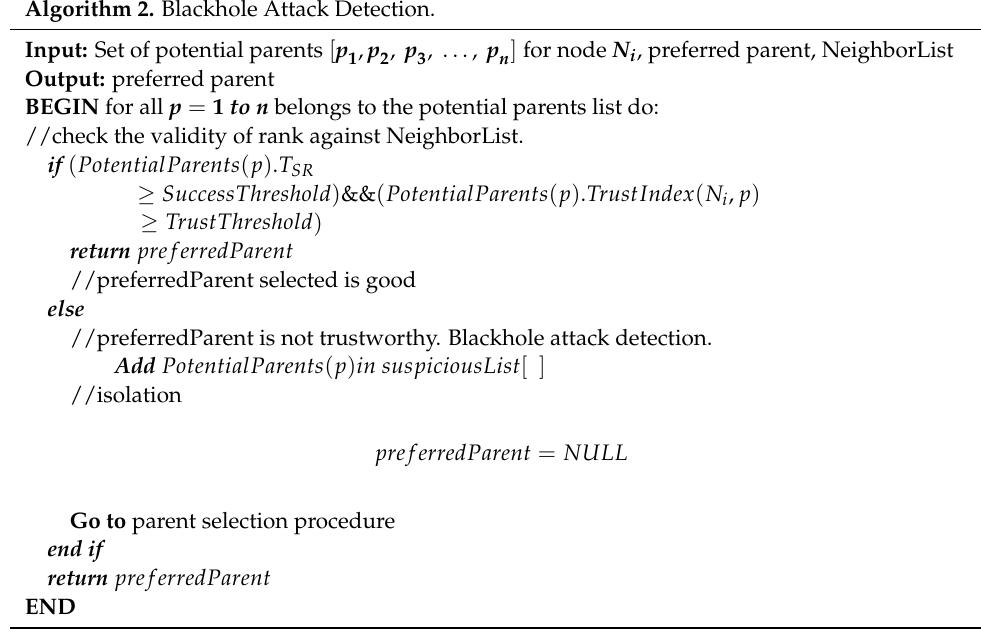
Algorithm 2. Blackhole Attack